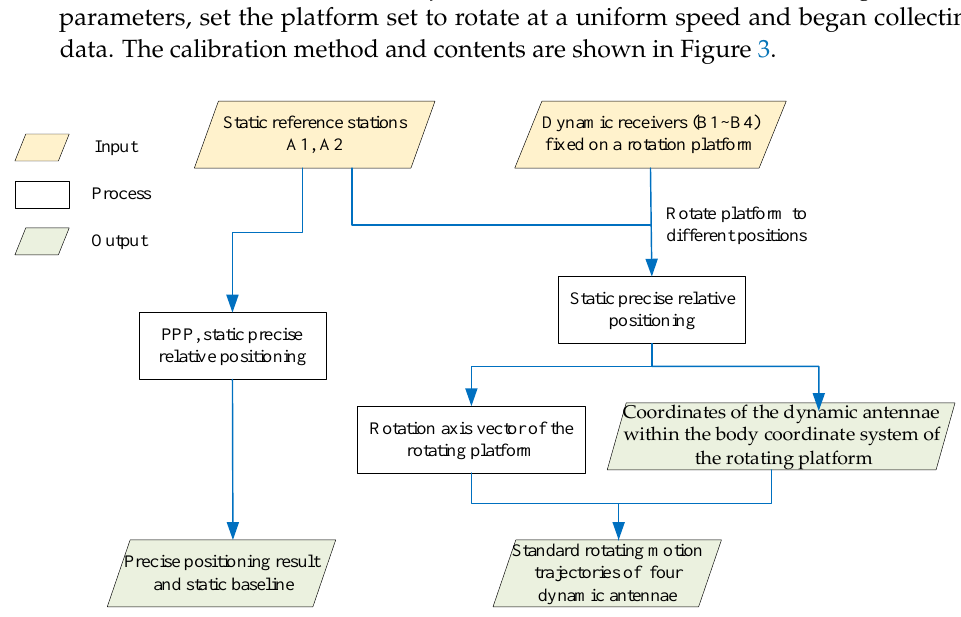
Figure 3. Procedure for calibrating coordinates and relative positions. (c) Calculating precise and effective relative positioning results. Calculate the relative position of each dynamic antenna relative to the static antennae according to the collected data. In addition, since the orientation of the rotation axis of the rotating platform is fixed, when the body coordinate system of the rotating platform is defined, the real position of all dynamic antennae can be described by an azimuth parameter (similar to yaw angle). The schematic diagram is shown in Figure 4.